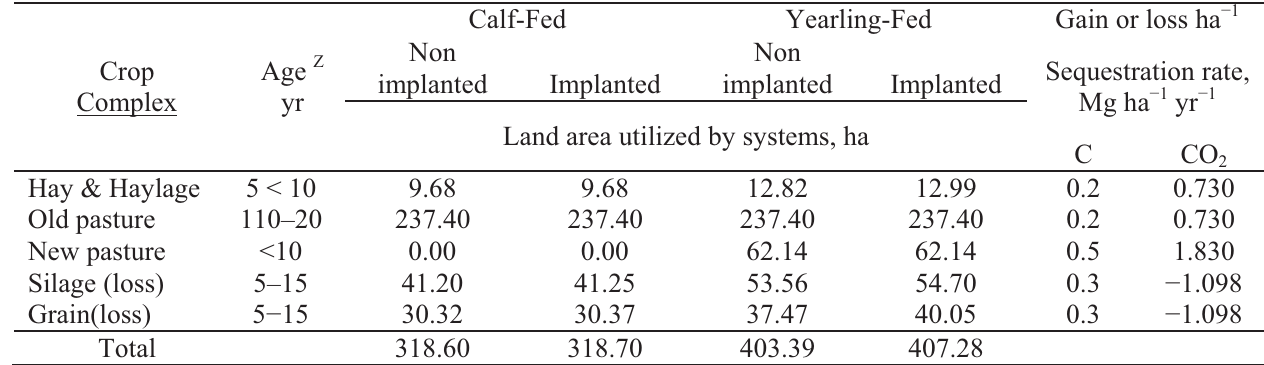
Table A9. Land areas by crop type with annual C-sequestration and CO emission coefficients.